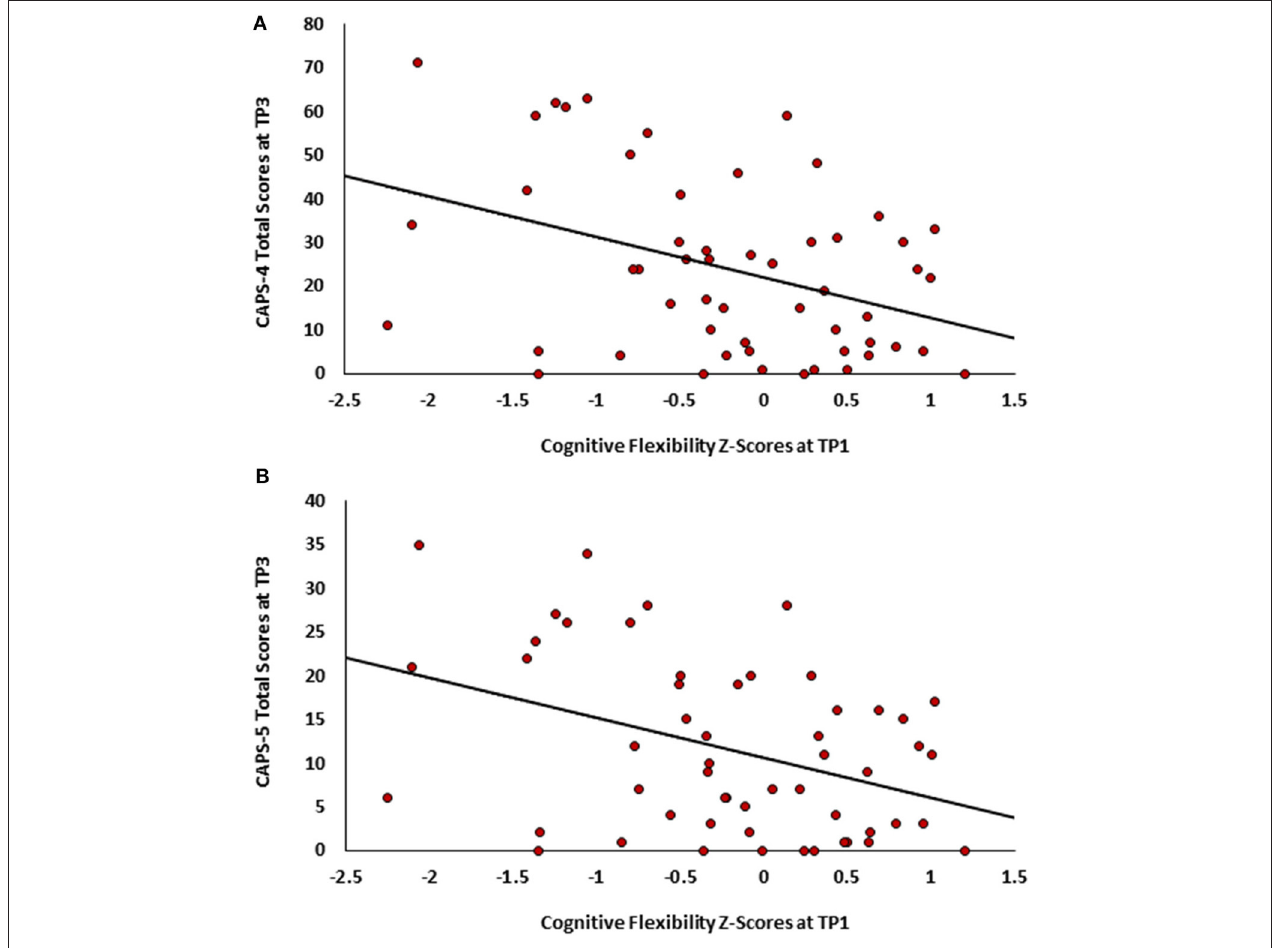
FIGURE 1 | Scatter plots depicting PTSD symptoms severity at TP3 as a function of cognitive flexibility at TPI. (A) - CAPS-4 total scores. (B) CAPS-5 total scores.